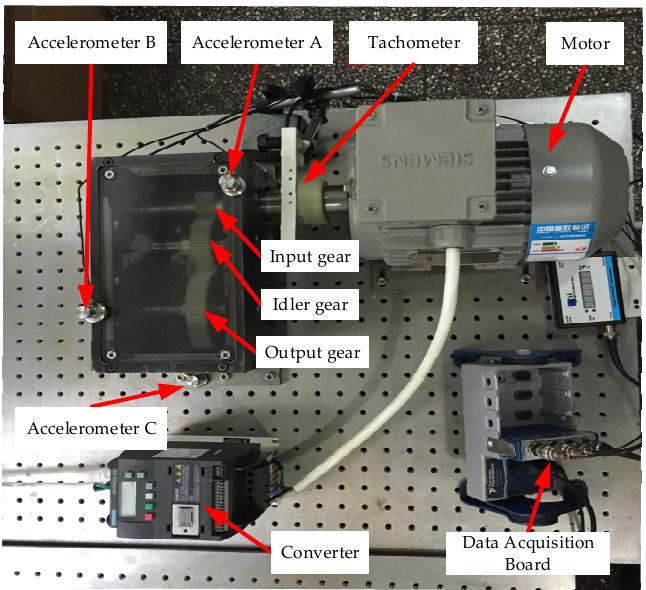
Figure 15. The gear test rig, which is from Zhejiang University and primarily contains a motor, three gears, and three accelerometers, and a data acquisition board.